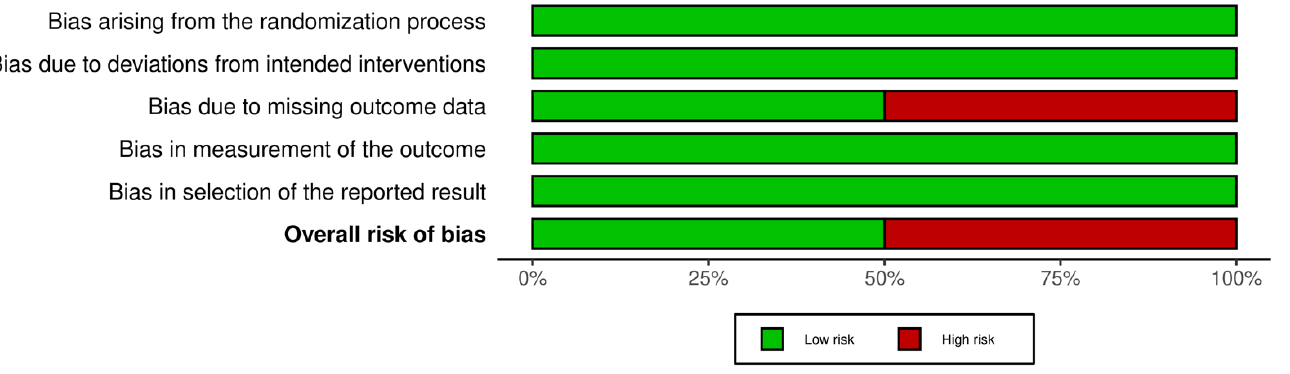
Figure 5. Summary plot of clinical trials.